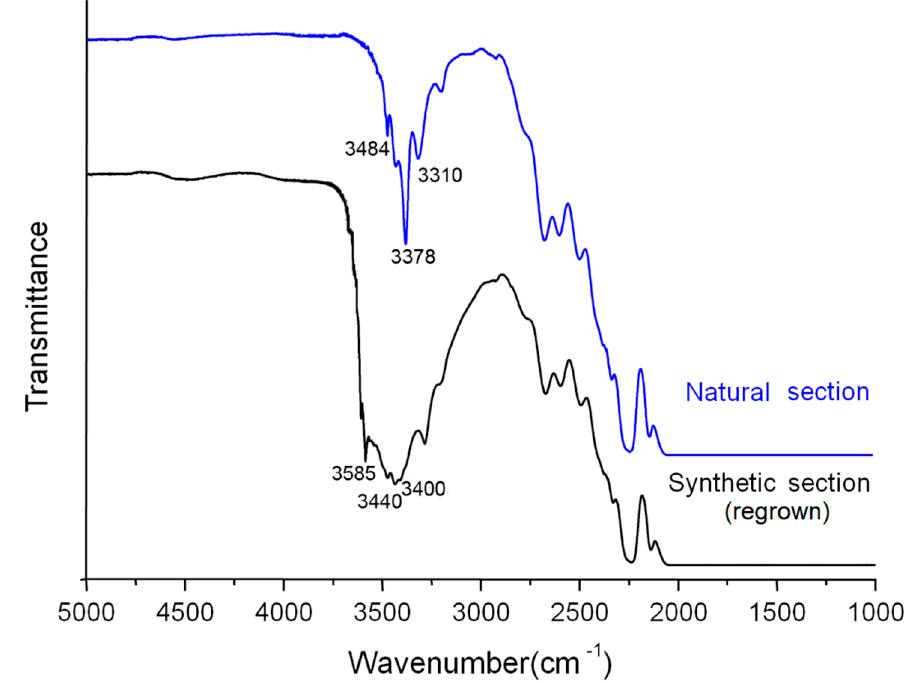
Figure 4. Infrared spectra of natural section and synthetic section of the regrown quartz crystal.